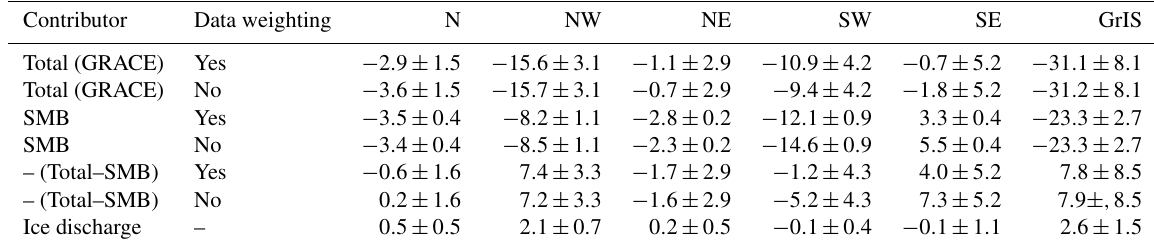
Table A2. Acceleration of mass change over the period 2003–2012 for individual drainage systems and the entirety of Greenland: total, SMB- related, and total–SMB residuals (GRACE minus SMB), as well as ice discharge (Gtyr − 2 ). The sign of total–SMB residuals is changed to make them directly comparable with ice discharge